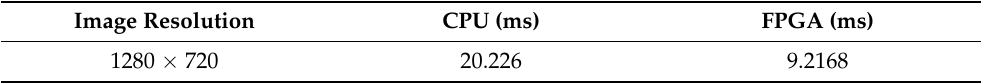
Table 2. Real-time performance comparison of line segment detection